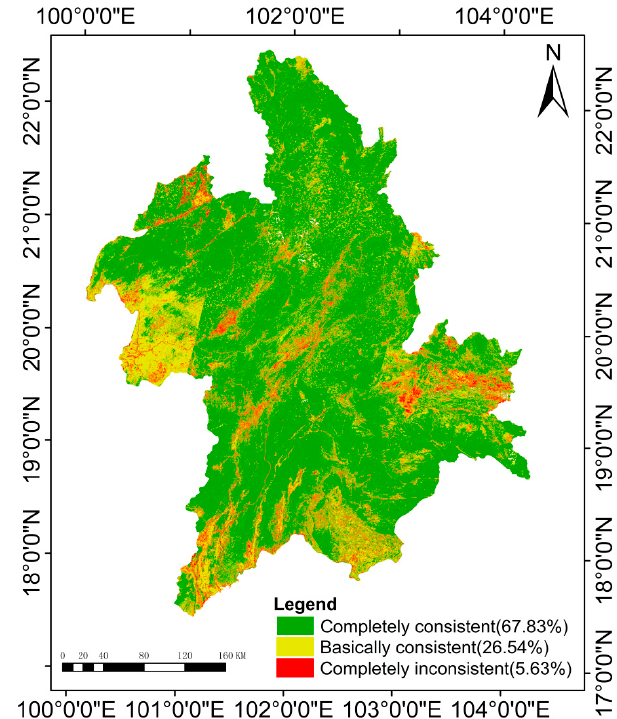
Figure 3. Spatial consistency maps of three land cover data. The percent numbers in the legend are the area proportion of each component. area proportion of each